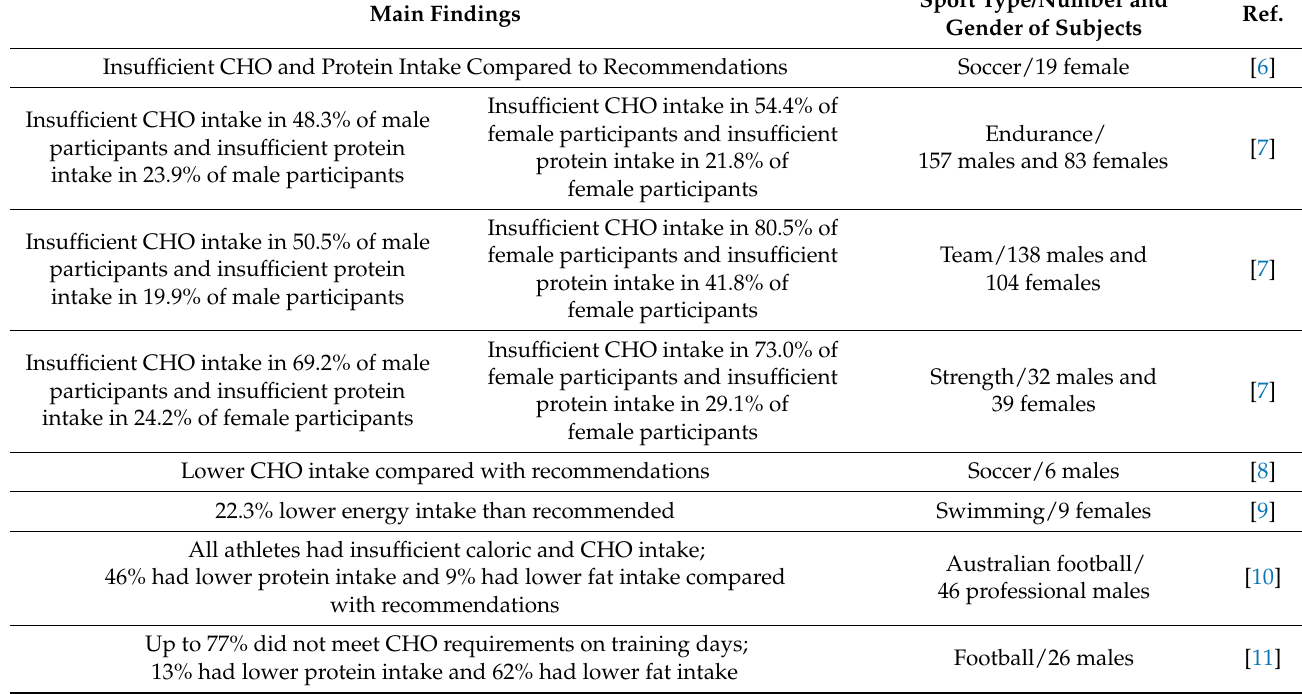
Table 1. Recommendations for supplement intake in different types of sports